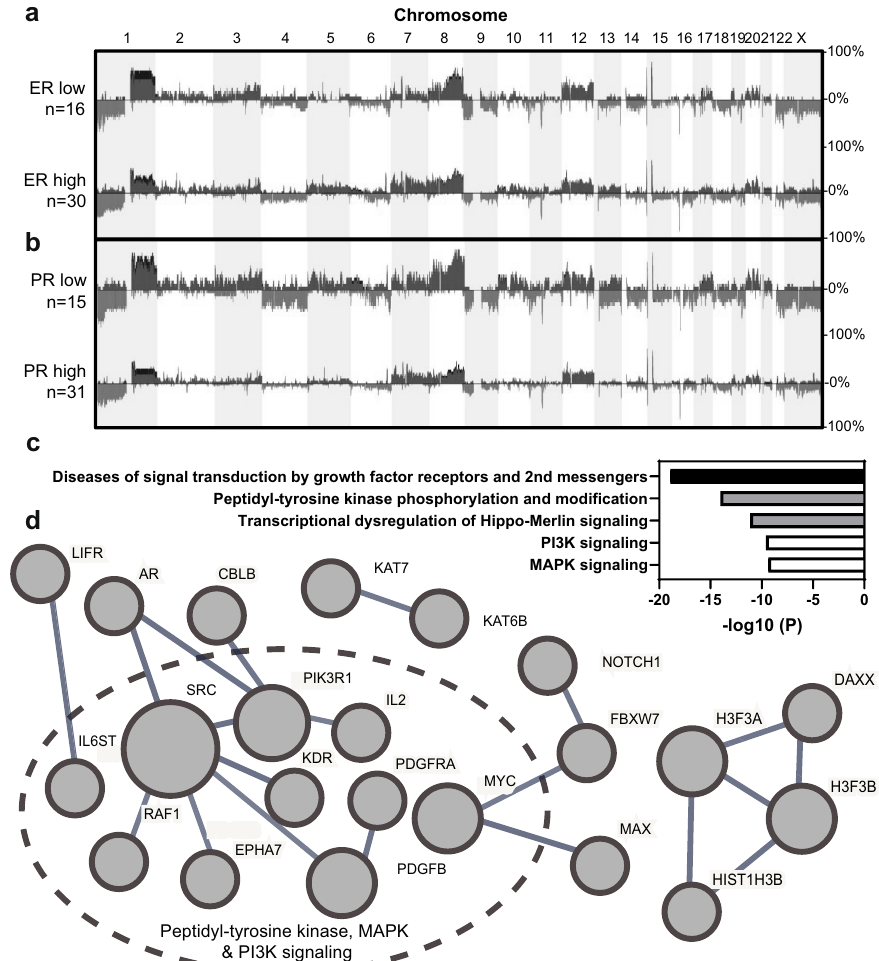
Fig. 1 Copy number analysis according to hormone receptor expression status. The frequency of global copy number changes in each chromosome is shown for combined cancer groups comparing ( a ) ER-low to ER-high cancers and ( b ) PR-low to PR-high cancers. CN gains and losses that were statistically signi fi cantly different between comparison groups (thresholds of p < 0.05 and at least 25% frequency difference) are shown in supplementary table 3. c Pathway analysis of all known cancer genes affected within signi fi cant CN regions of PR-low compared to PR-high LGSOCs are shown and ( d ) physical protein – protein interactions are shown in network